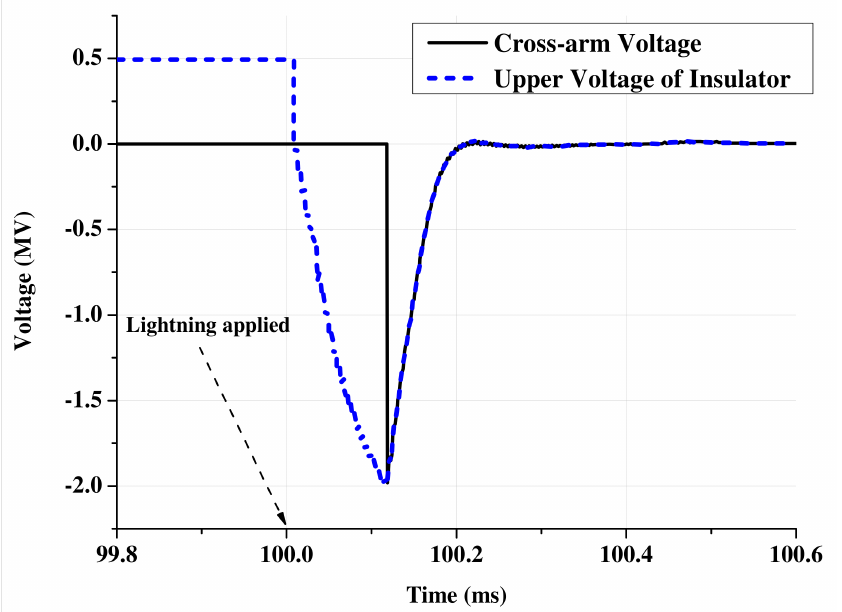
Figure 21. Voltage at tower cross-arm point and upper point of insulator in the case of shielding failure at 300